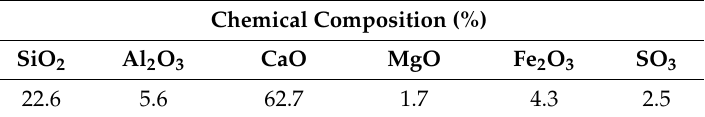
Table 3. Properties of natural granite coarse aggregate. Table 2. Chemical composition of Portland cement.